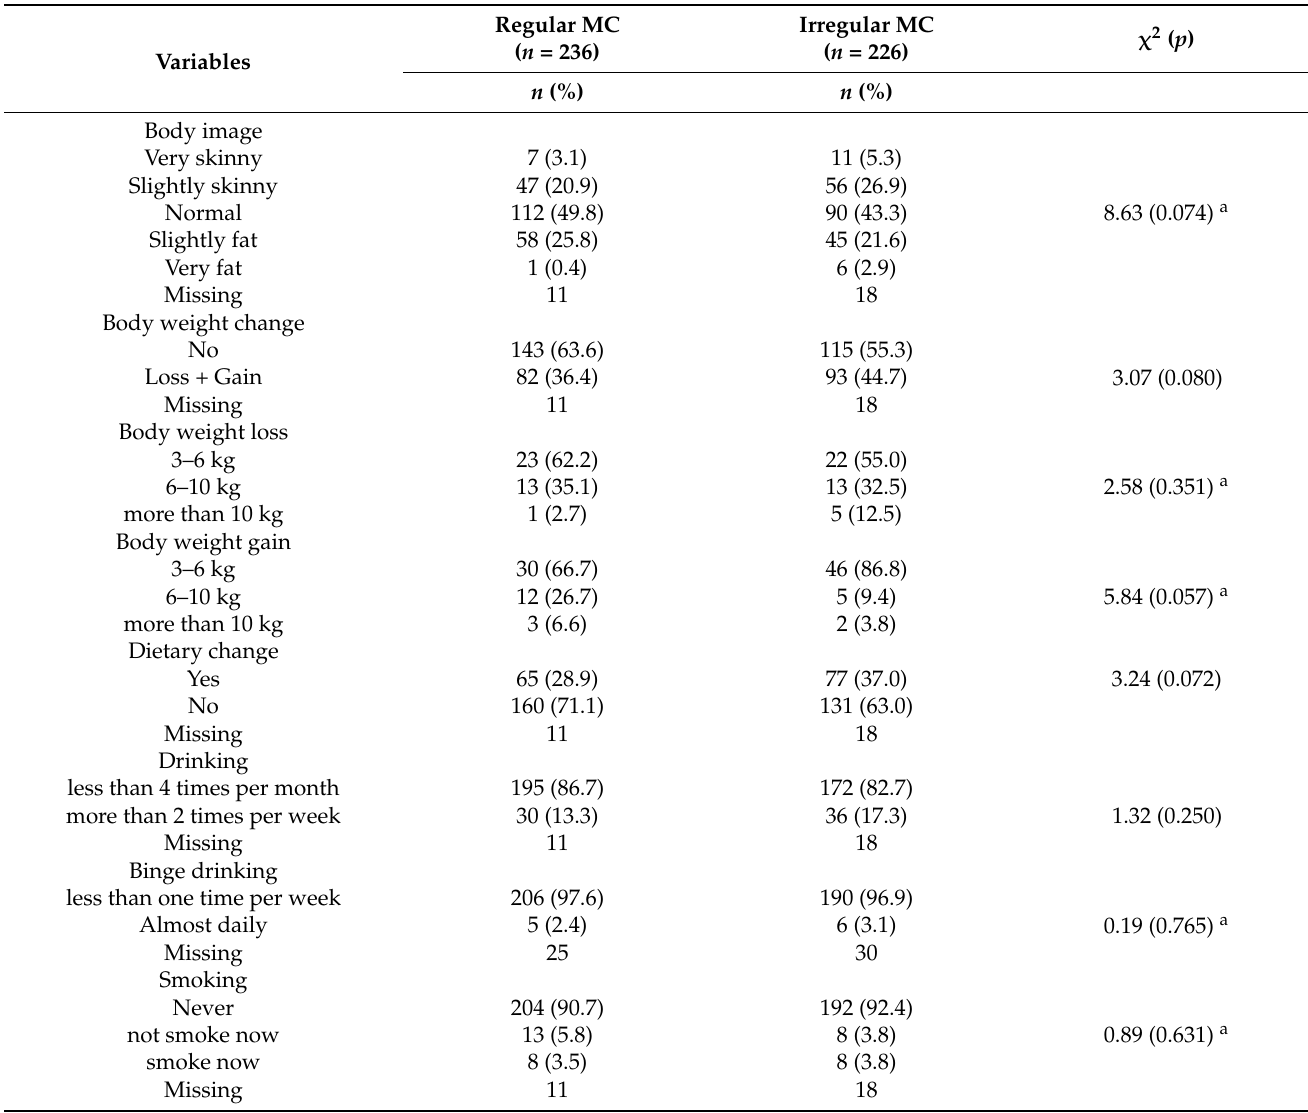
Table 2. Health-related behaviors according to menstrual cycle regularity ( n =